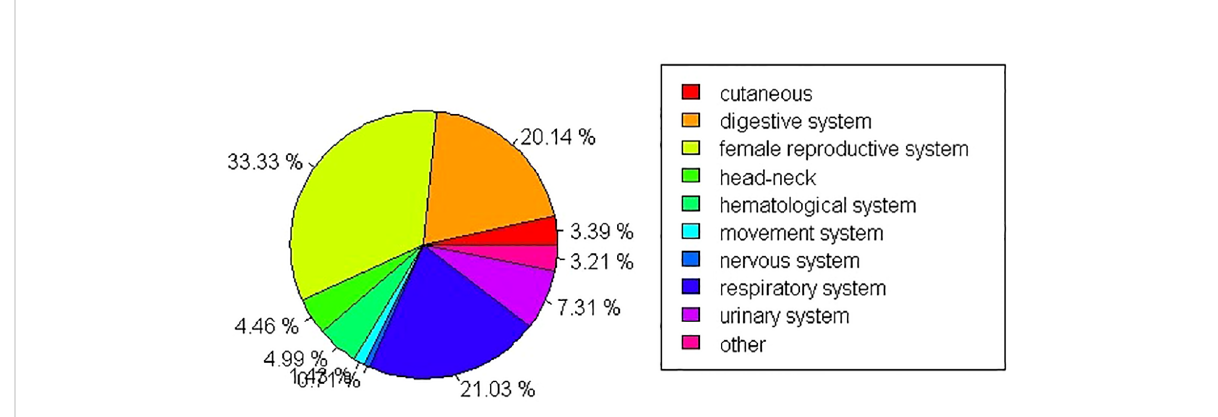
FIGURE 2 The percentages of SPM onset